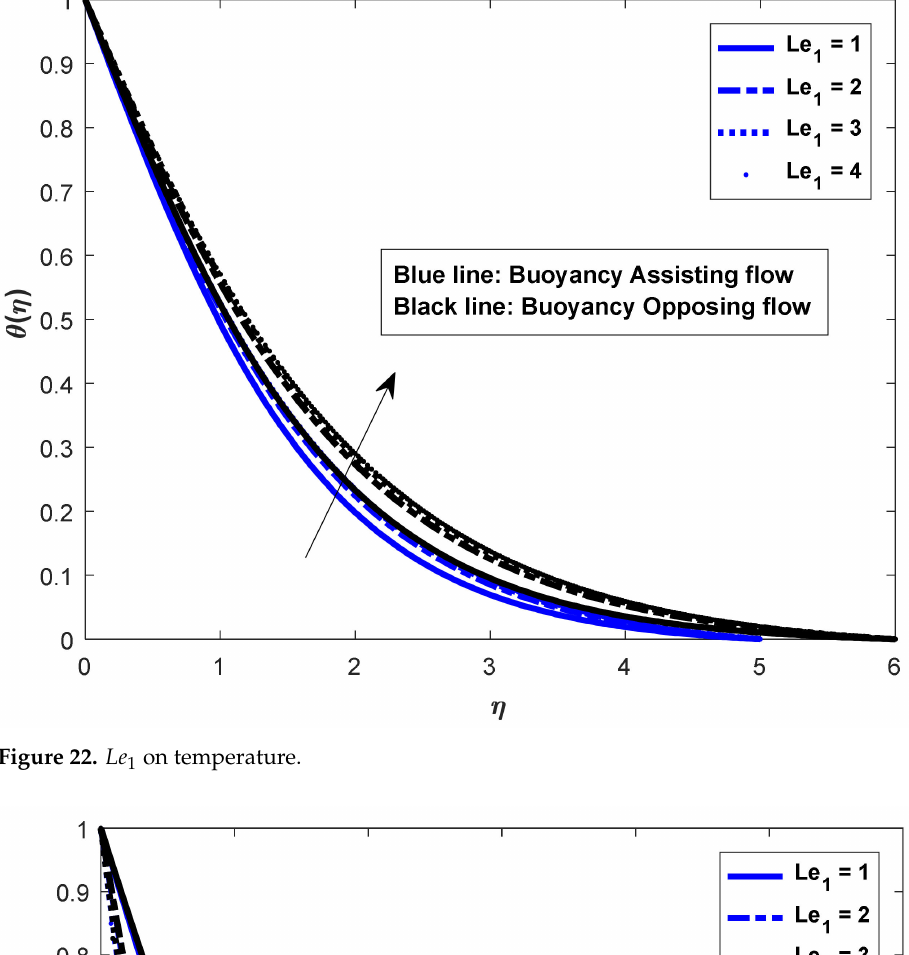
Figure 22. Le 1 on temperature.